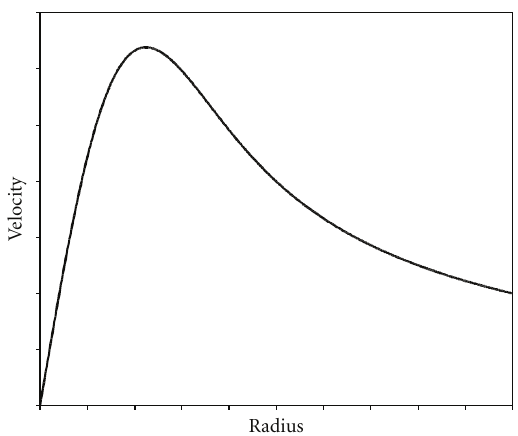
Figure 2: Tangential velocity structure as a function of radius for a Rankine